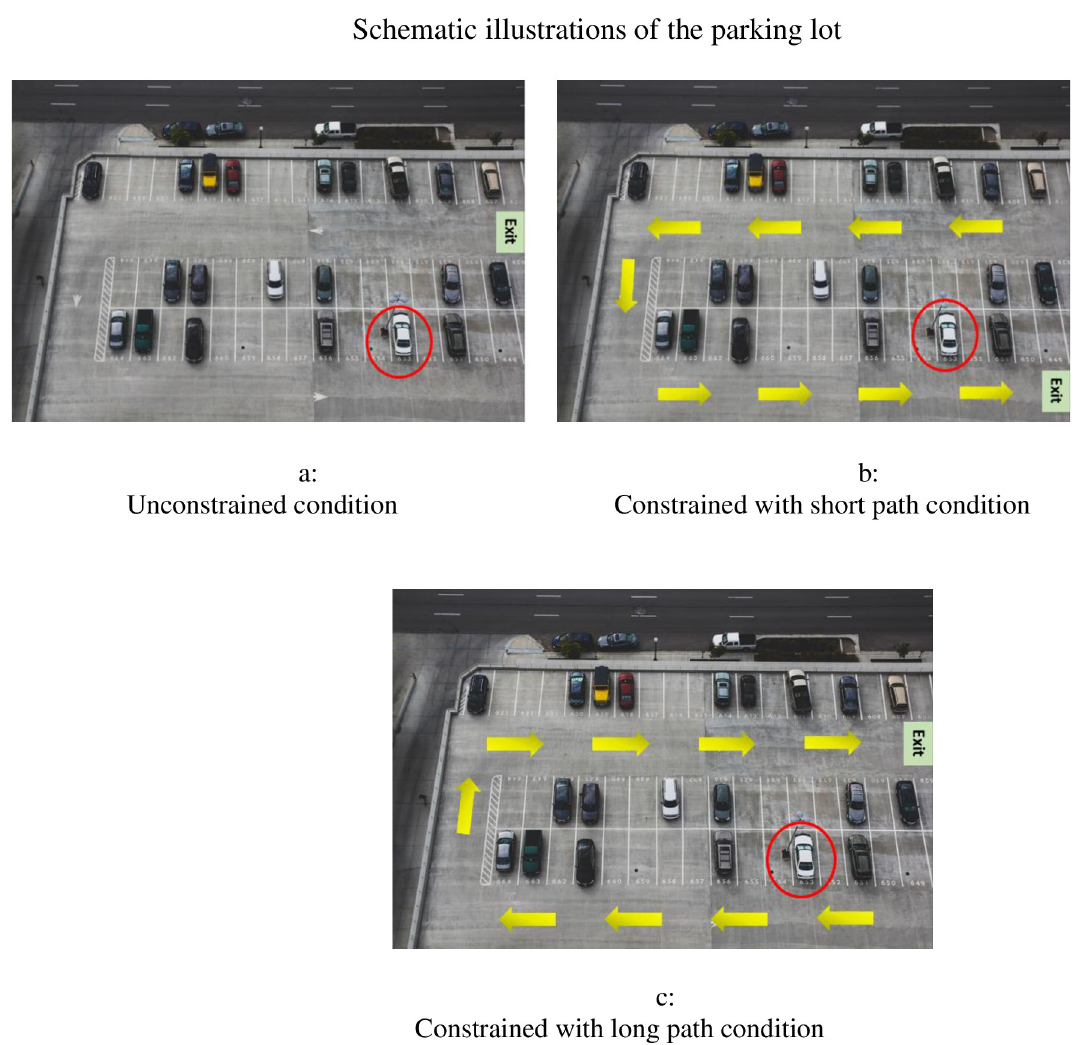
Fig 2. Schematic illustrations of the parking lot (Study 3). a. Unconstrained condition. b. Constrained with short path condition. c. Constrained with long path condition.